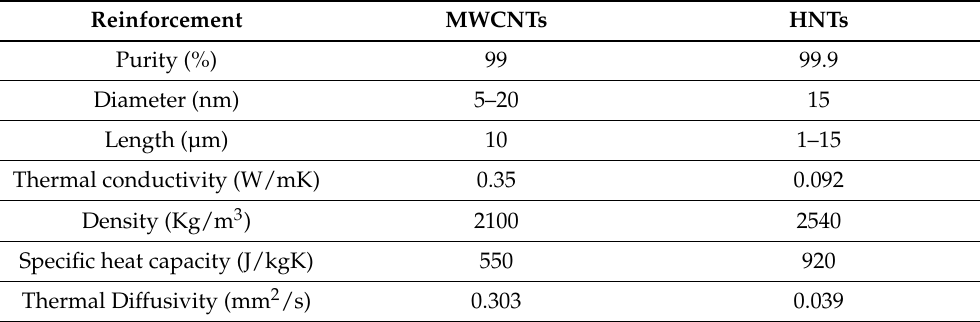
Table 1. Specifications and thermophysical properties of two types of reinforcements considered in the present